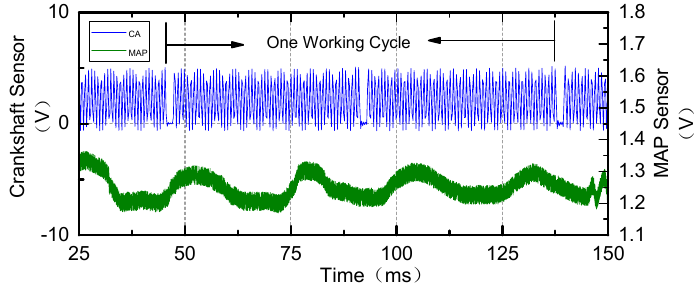
Figure 2. The recorded air pressure signal.